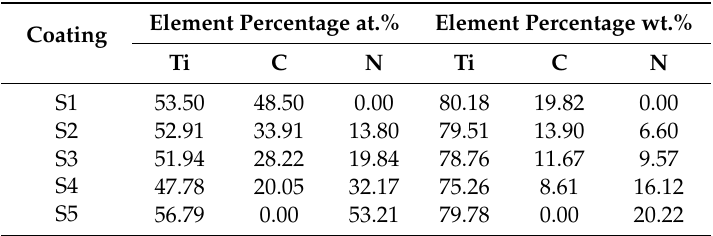
Table 4. Chemical composition of tested